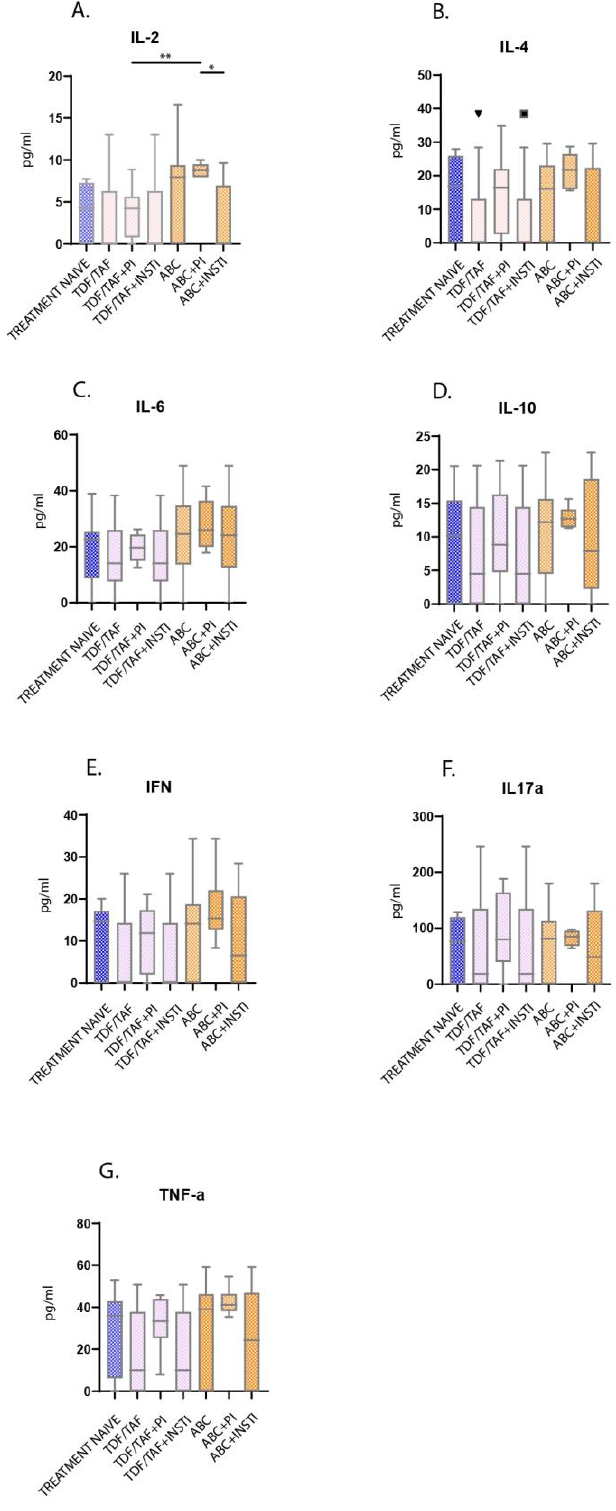
Figure 3. Inflammatory response assessment, as reflected in major pro- and anti-inflammatory mediator levels ( A – G ). Tukey box plot reveals significantly elevated levels of IL-2 in patients receiving combination of ABC + PI compared to patients on TDF/TAF + PI or ABC + INSTI. IL: Interleukin, TNF: tumor necrosis factor, IFN: interferon, TAF: tenofovir alafenamide, TDF: tenofovir disoproxil fumarate, ABC: abacavir, PI: protease inhibitor, INSTI: integrase strand transfer inhibitor; PRU: platelet reactivity units; ** denotes p < 0.01, * p < 0.05.